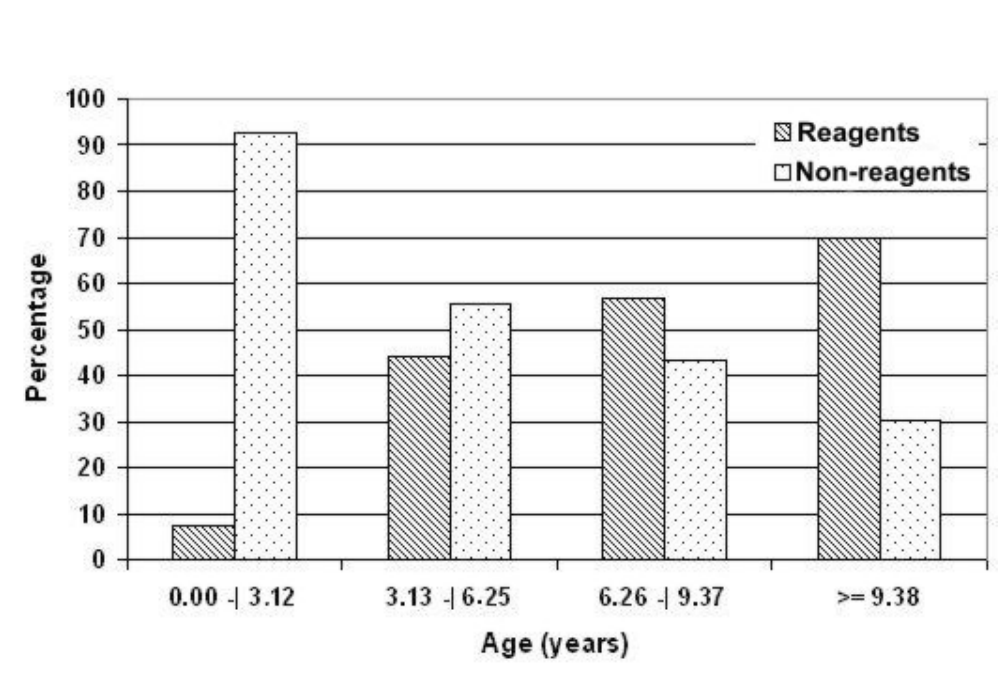
Figure 1. Results of microscopic sero-agglutination for Leptospira spp in 158 samples of equine serum, according to the age, Botucatu,